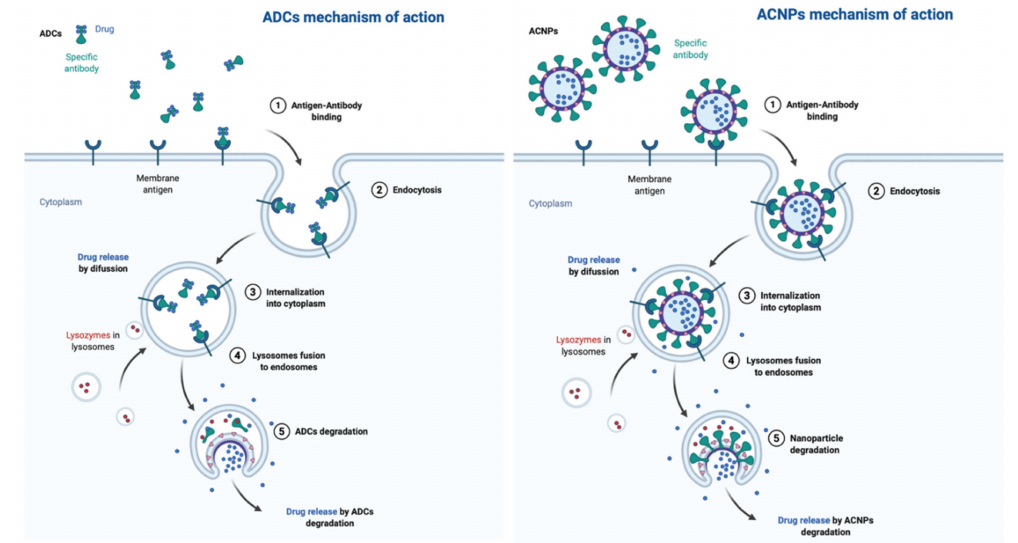
Figure 3. Action mechanism of antibody-conjugated nanoparticles (ACNPs) and